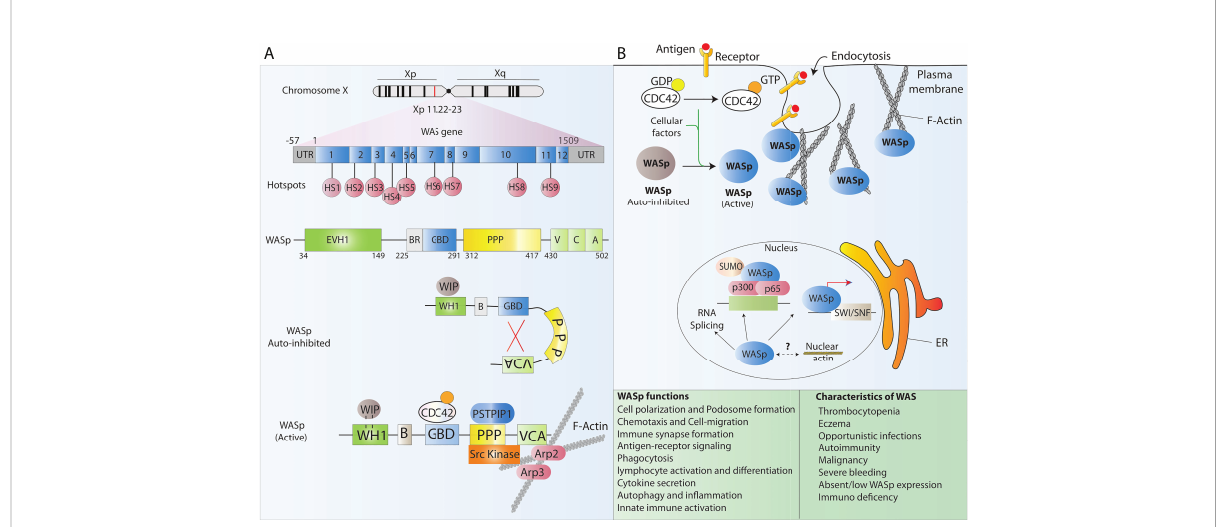
FIGURE 1 WASp structure and function. (A) Schematic representation of the WAS gene and its major functional protein domains. The WAS gene is located on the X chromosome and comprises 12 exons. Disease-causing mutations in WAS patients are scattered around the whole gene, however, 9 mutational hotspots (HS) have been detected in patients. WASp is made of 5 different domains and presents in the cell cytoplasm in an auto- inhibited conformation at resting state and leads to actin polymerization after receptor stimulation. (B) The many functions of WASp in lymphoid and myeloid immune cells relate to its role in regulating the polymerization of new branched actin fi laments. Besides, WASp plays an important role as a scaffold protein in the regulation of some nuclear functions such as chromatin